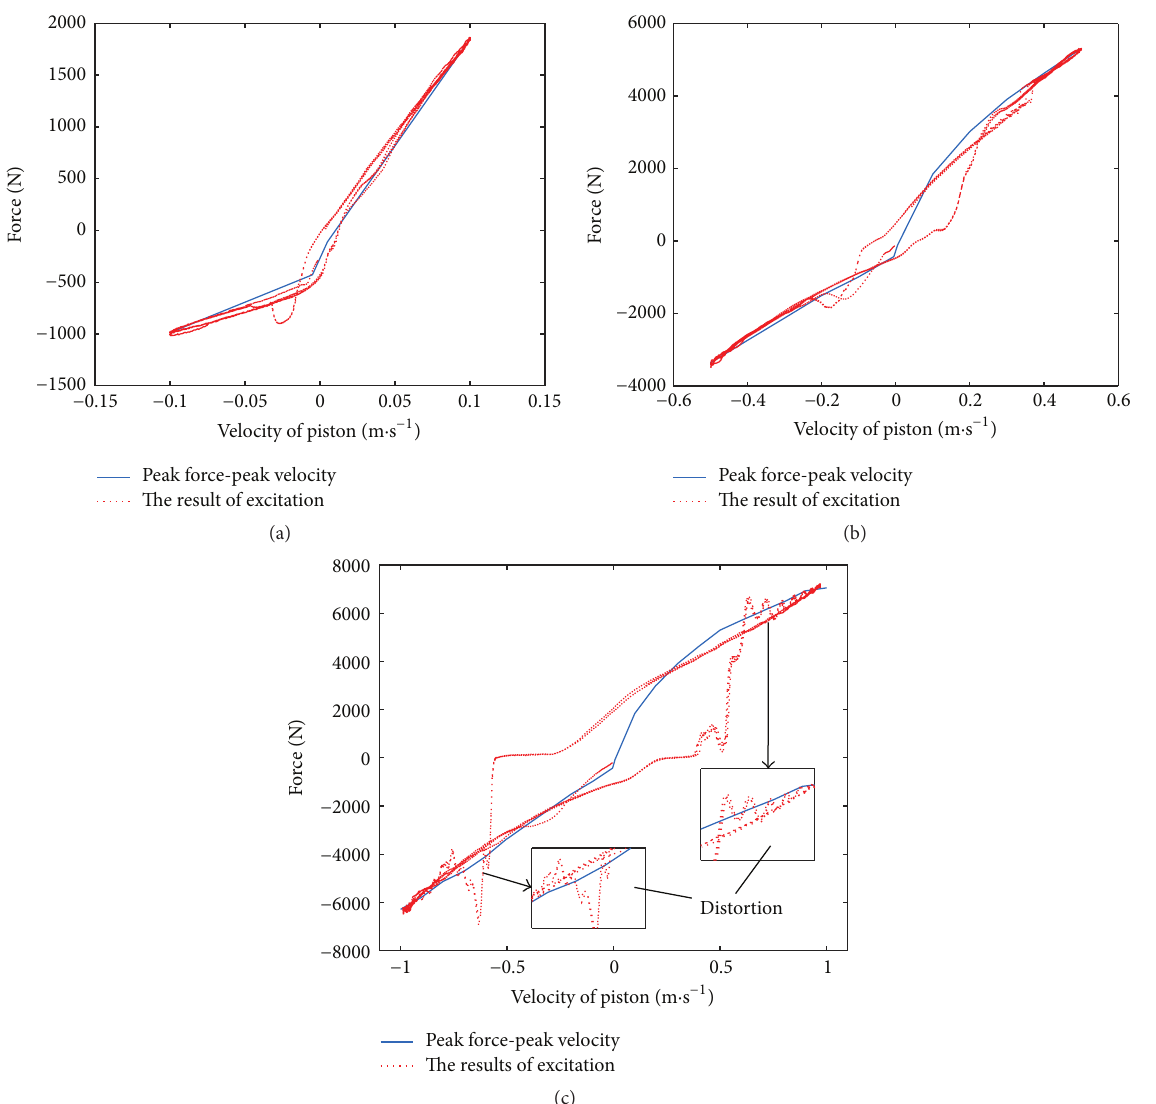
Figure 5: Comparison of the peak force-peak velocity curve and testing results: (a) sine 0.3537 Hz-45 mm; (b) sine 1.7684 Hz-45 mm; (c) sine 3.5368 Hz-45